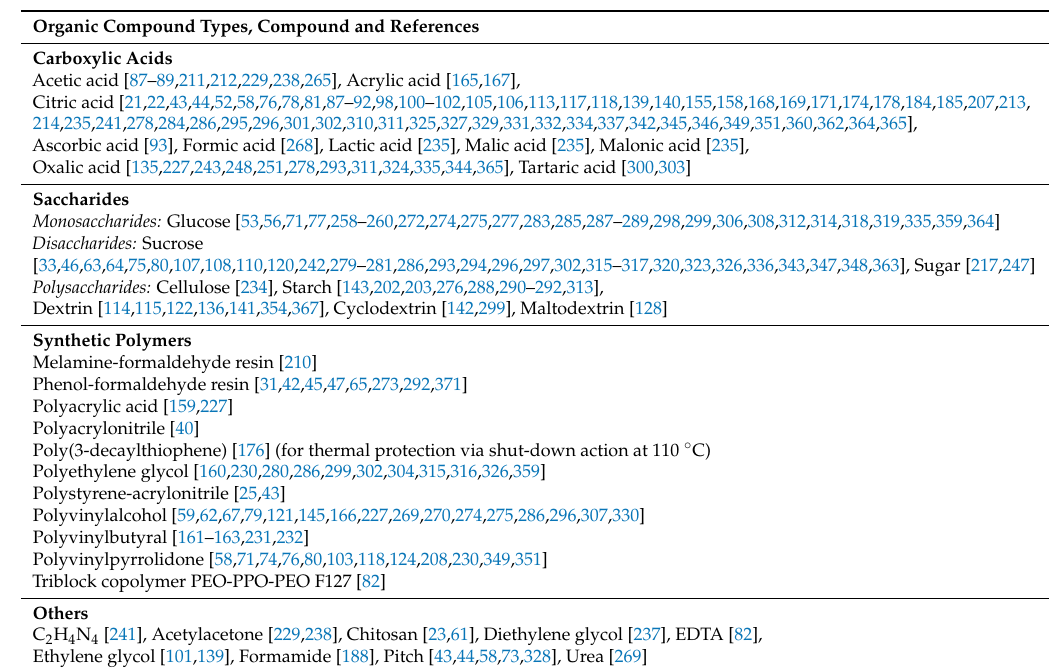
Table 4. Organic (macro)molecules used for the formulation of solutions/suspensions in view of spray-drying preparation of electrode